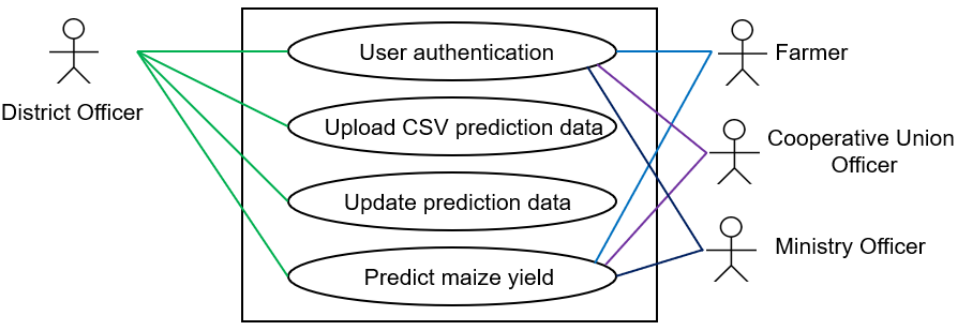
Figure 1. Use case diagram describing users’